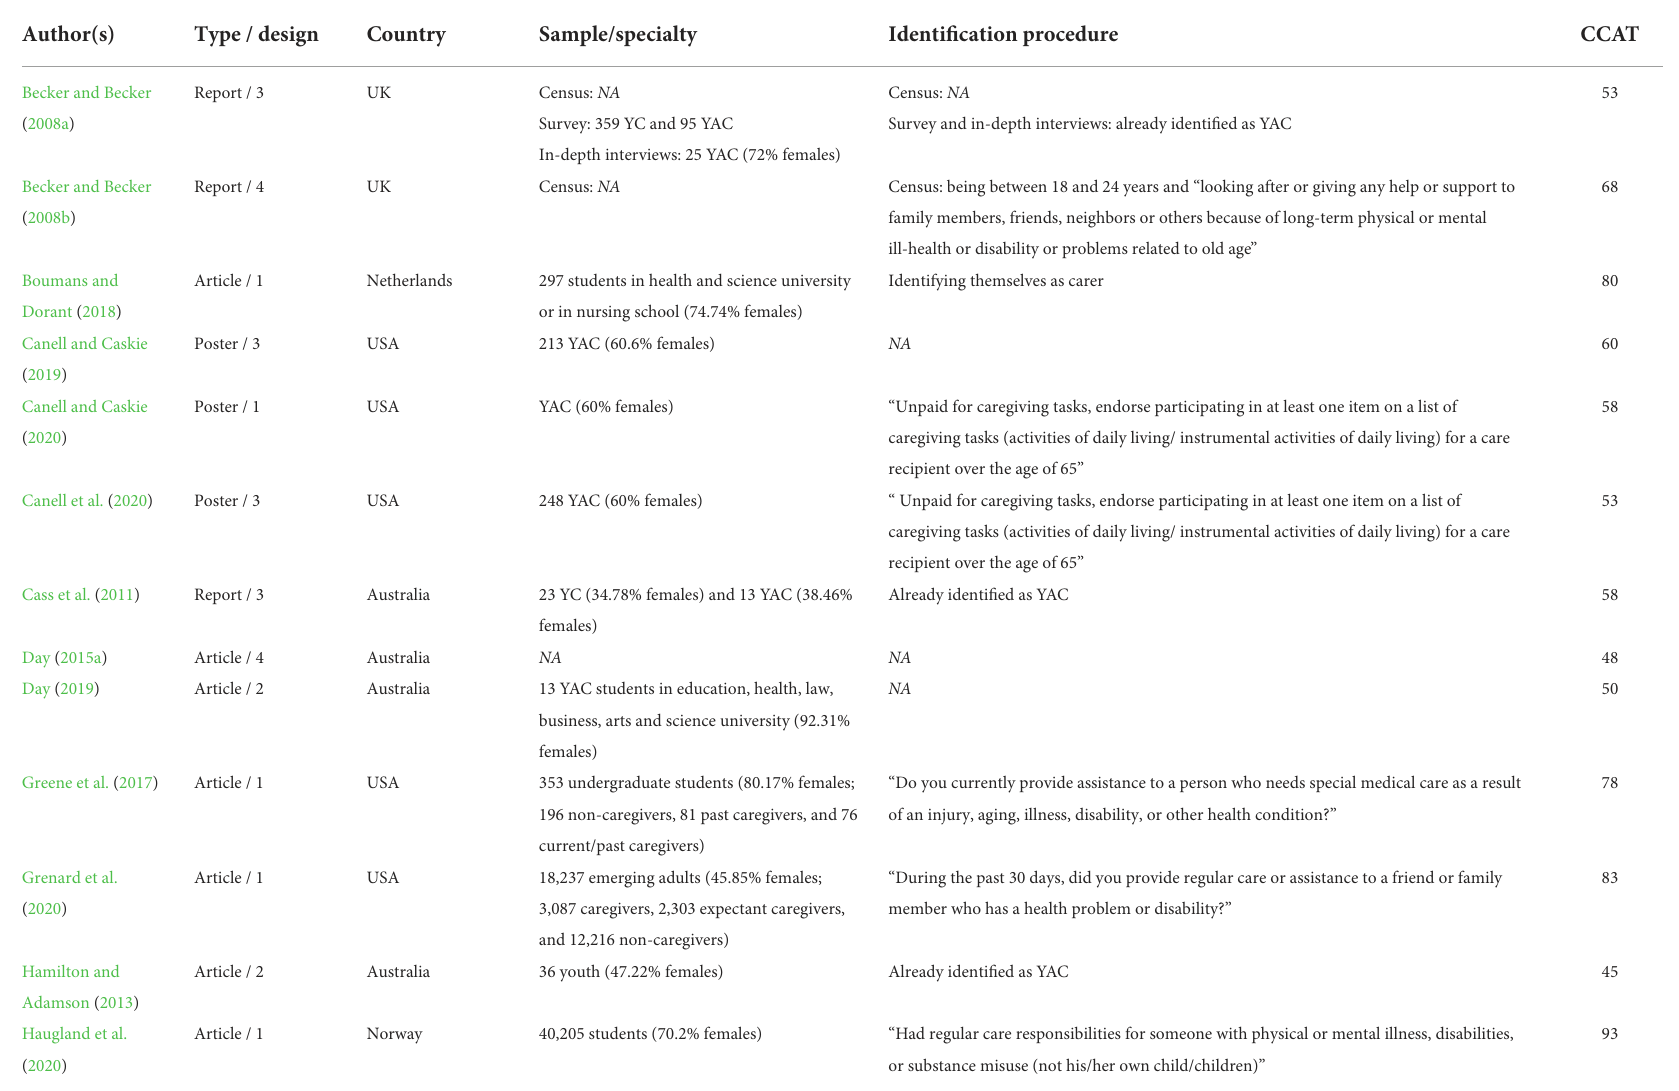
TABLE 1 Included study type, country, sample, identification procedure, and CCAT